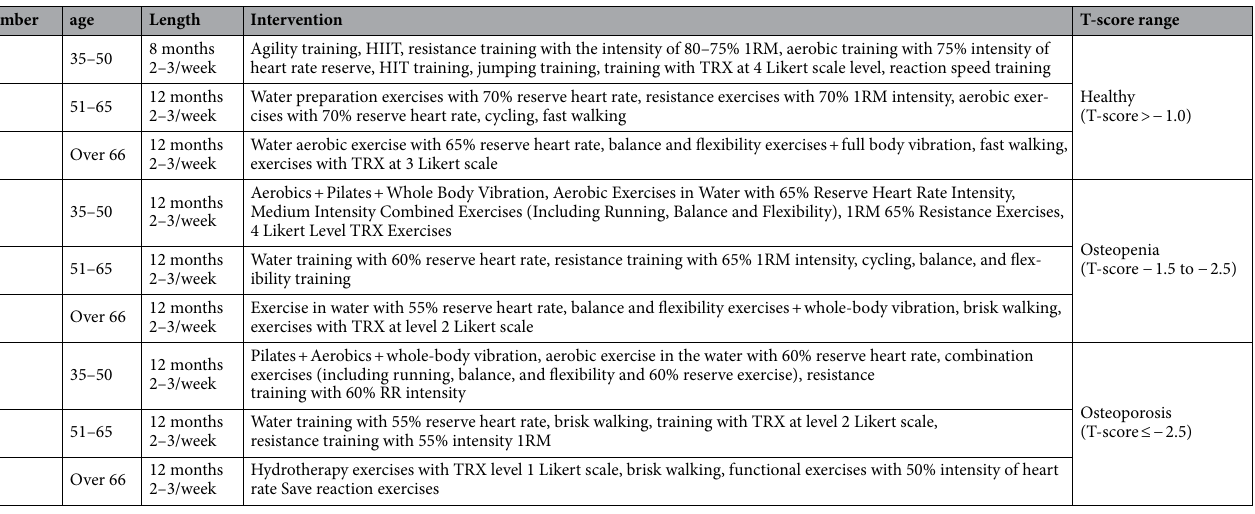
Table 6. Recommended exercises for women in the three categories of healthy, osteopenia and OP. *Within the examined range, different classification algorithms were used. DT Decision tree, RF Random forest, KNN k-nearest neighbor, SVM Support vector machine, GB Gradient boosting, ET Extra trees, AB Ada Boost, ANN- MLP Artificial neural network multilayer perceptron.